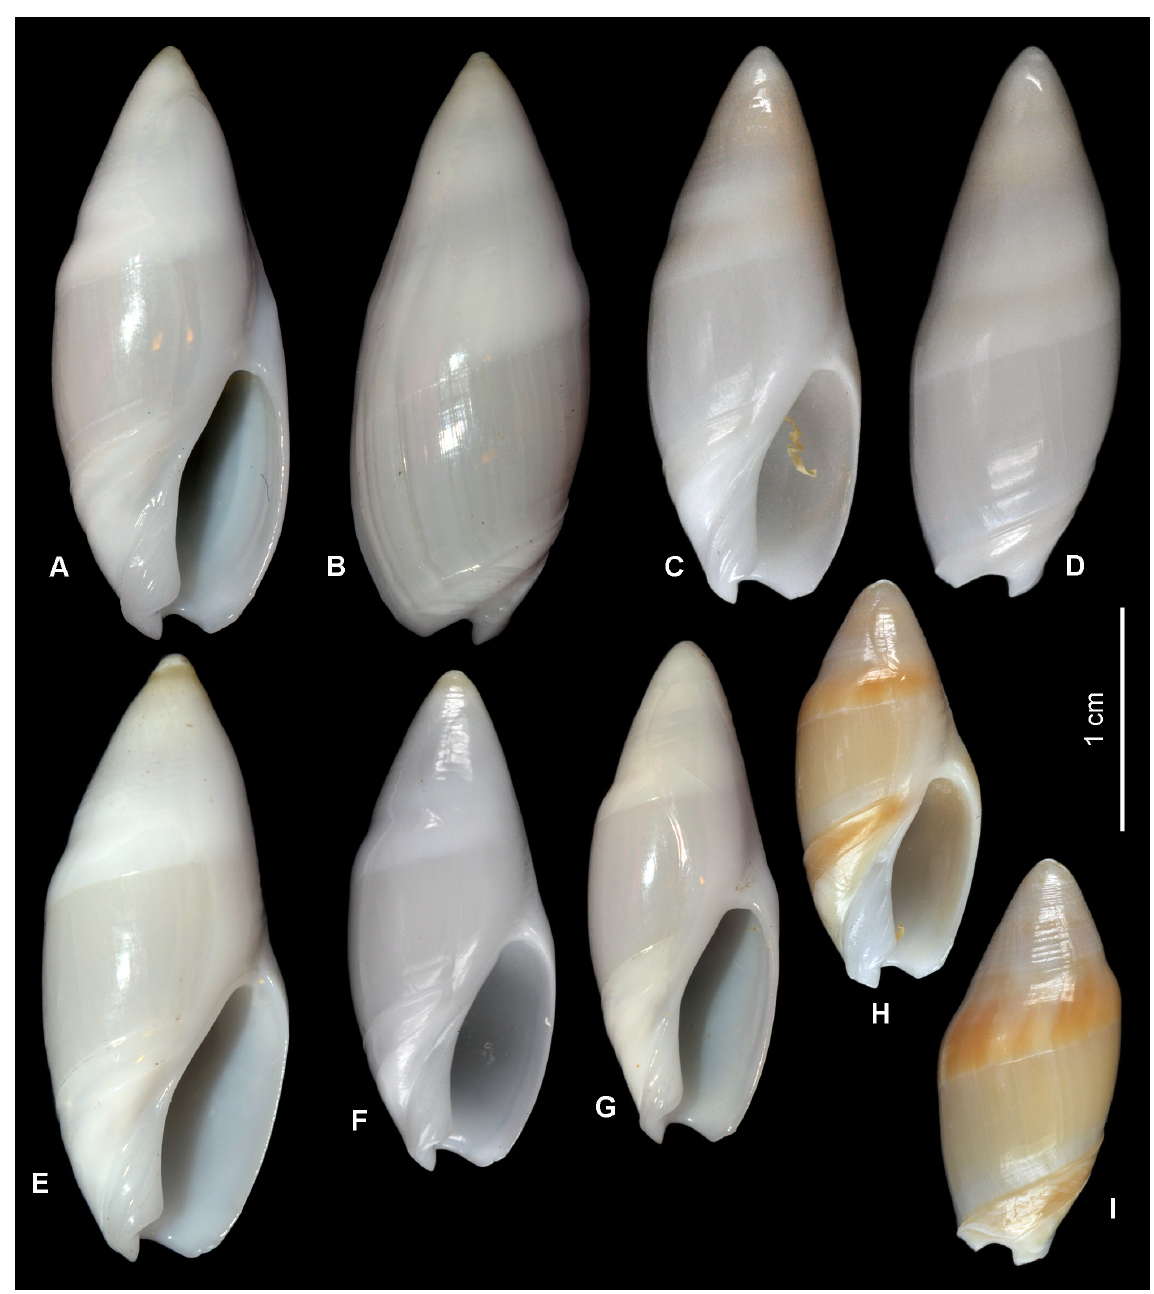
Fig. 15. Amalda alabaster sp. nov. A–B . Holotype, MNHN IM-2007-43627, SL 26.7 mm. C-D . MNHN IM-2007-43583, SL 24.8 mm. E . MNHN IM-2007-43621, SL 27.1 mm. F . MNHN IM-2007-43626, SL 22.2 mm, specimen not sequenced. G . MNHN IM-2007-43633, SL 22 mm, specimen not sequenced. H–I . A. cf. alabaster , MNHN IM-2013-63897, SL 18.1 mm. Shells at the same scale, all